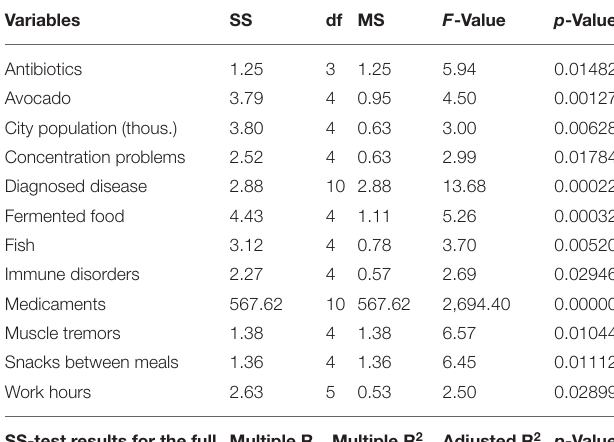
TABLE 5 | Association between the analyzed behaviors and the country of residence in the study group. Variables